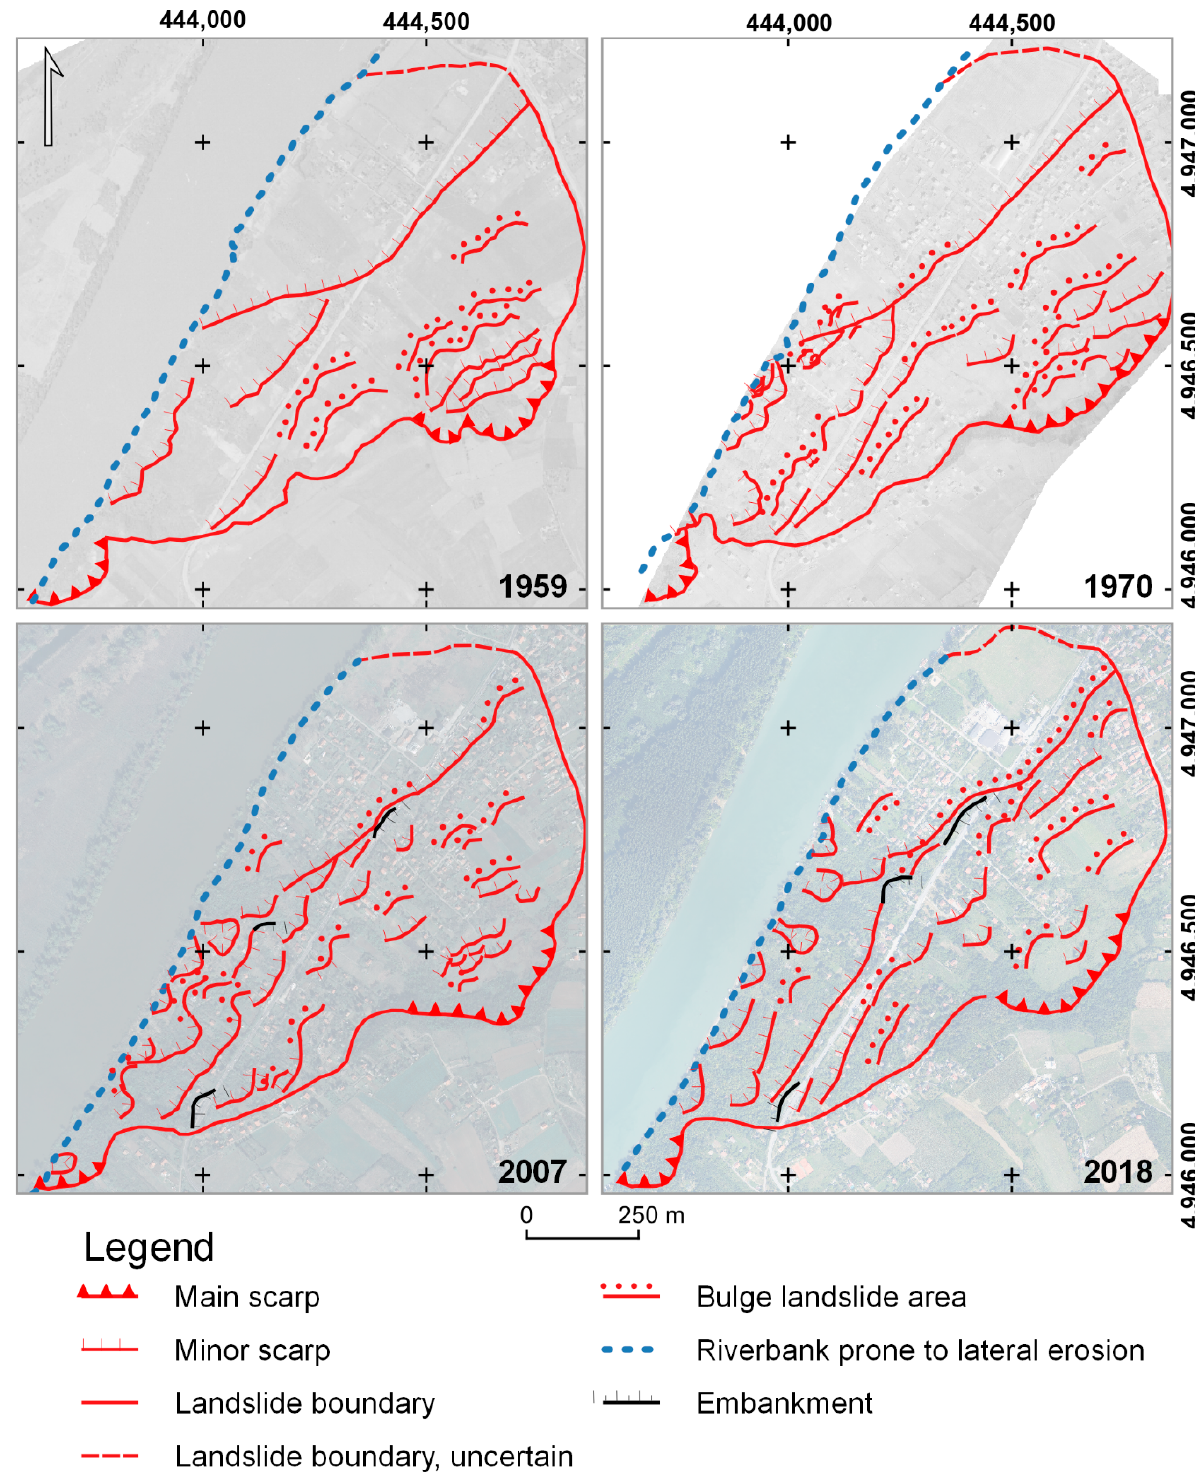
Figure 5. Photogeological maps of isolated geomorphological forms based on stereo pairs generated from orthophotos and corresponding DEMs for four selected recording epochs (1959, 1970, 2007, and 2018).